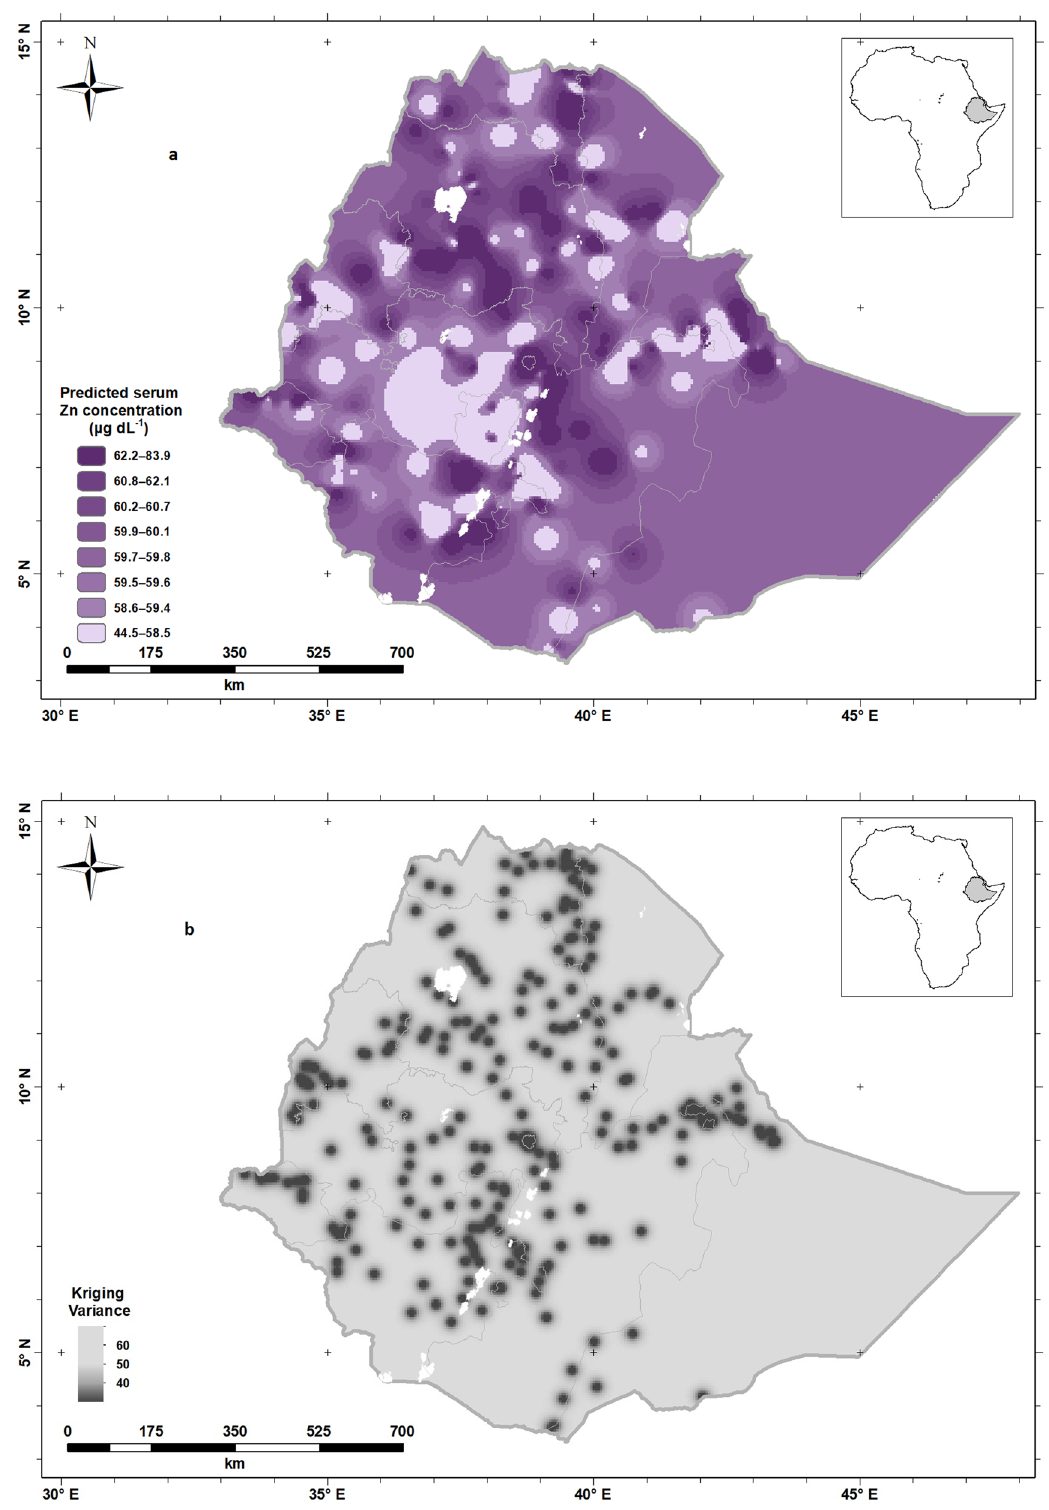
Figure 3. Predicted mean serum Zn concentration ( a ) and Predicted serum Zn variance ( b ), for women of reproductive age in Ethiopia. Created using ArcGIS 10.4.1. ESRI ArcGIS Desktop: Release 10. Environmental Systems Research Institute, Redlands.